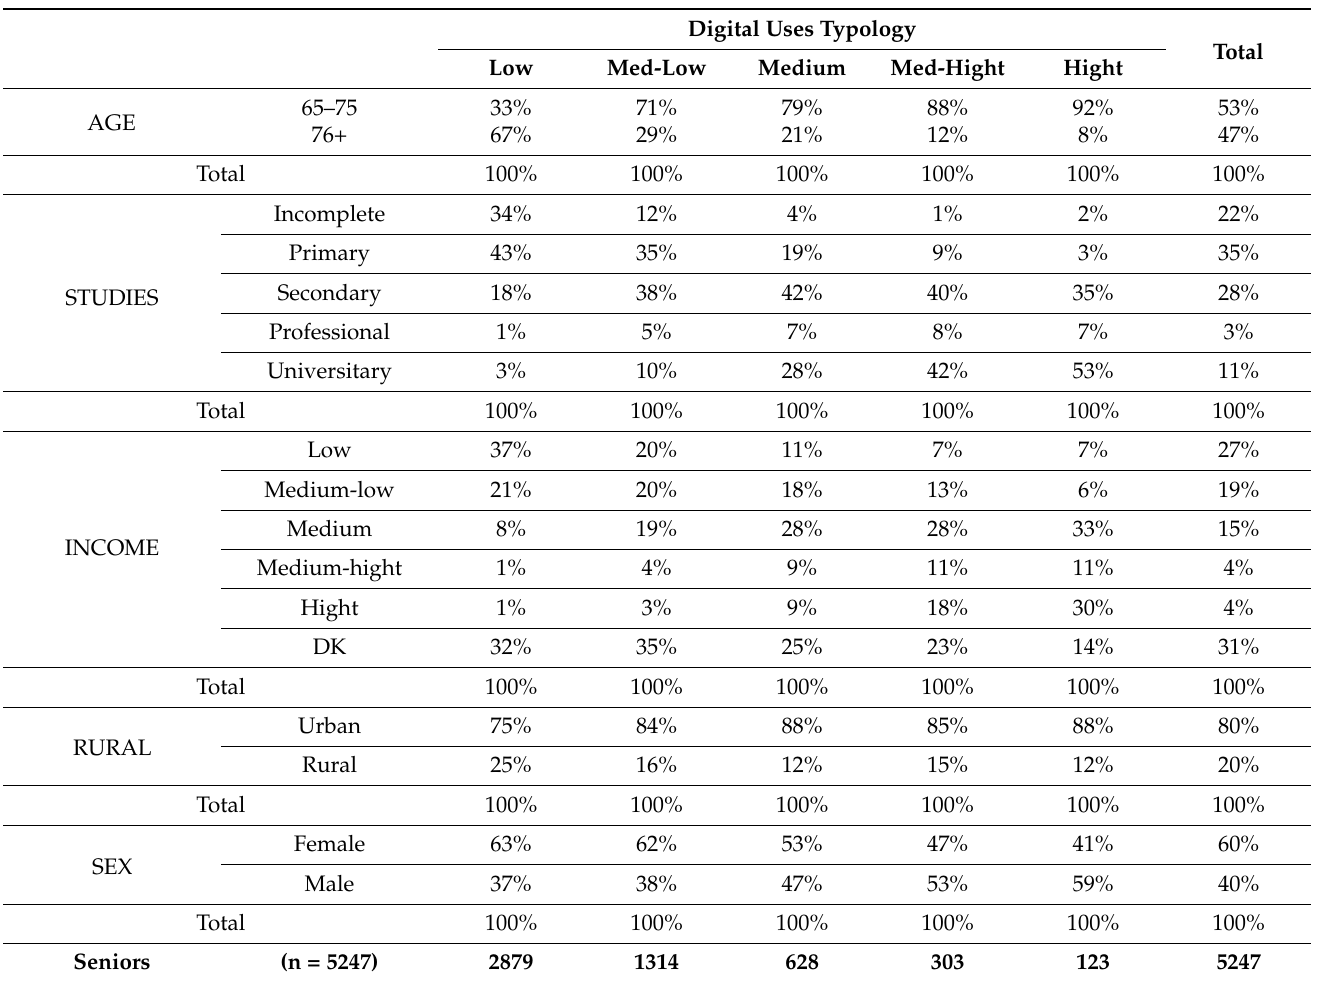
Table 5. Digital uses typology by digital